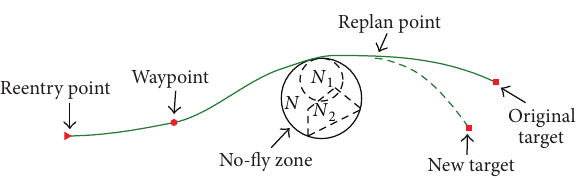
Figure 4: Example of the geographic constraints for glide flight.